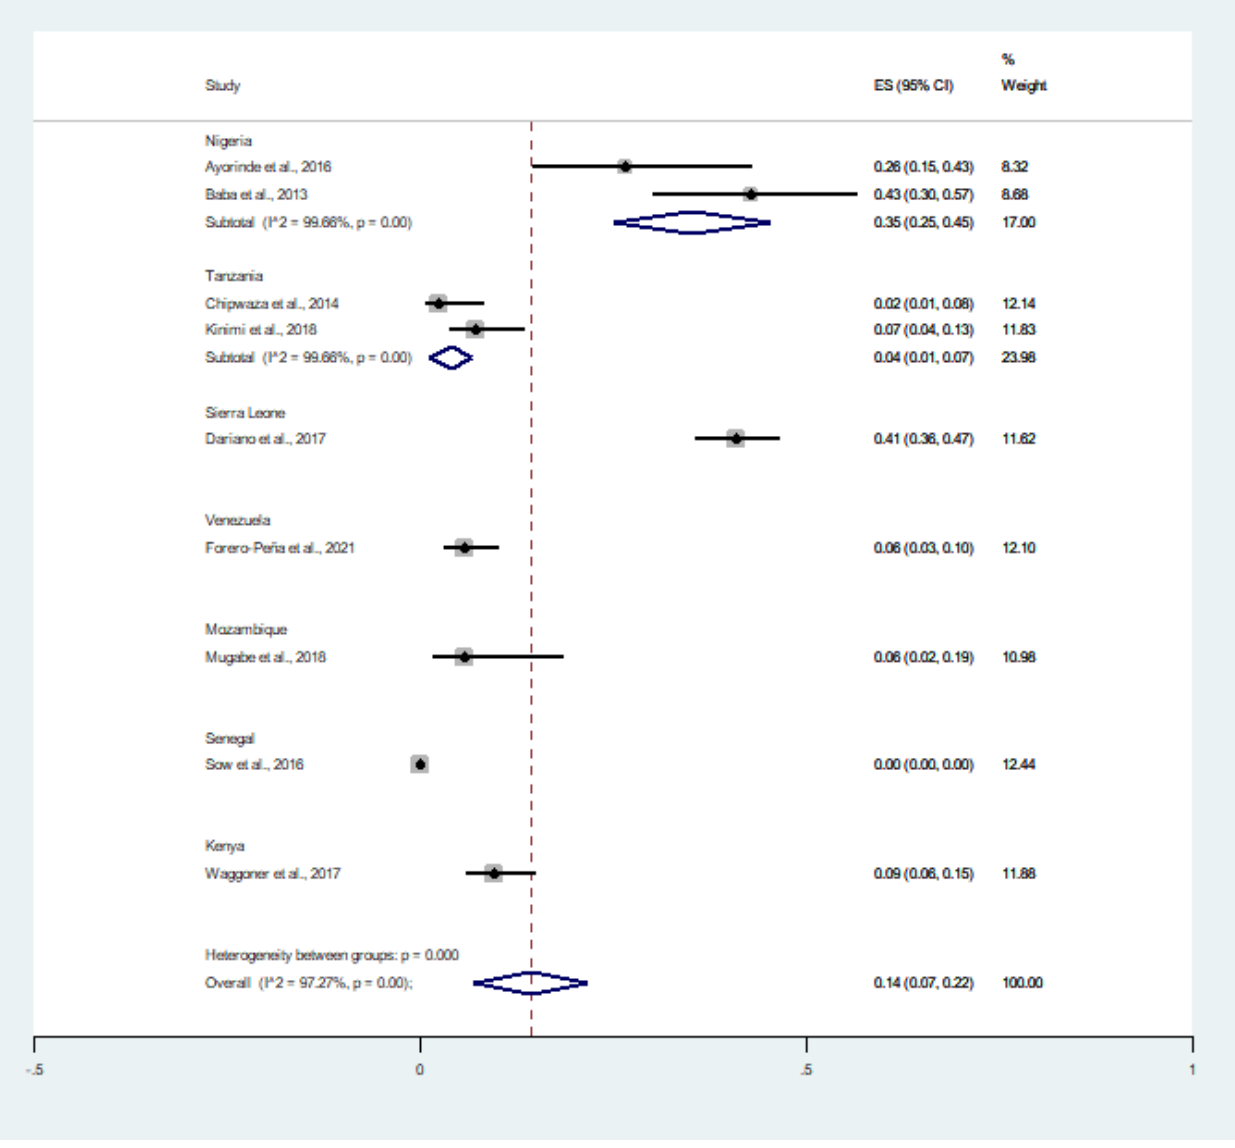
Figure 5. Prevalence of CHIKV infection among malaria patients by country: % weighted, the impact proportion of each study to the pooled effect; the black dot symbol on the black horizontal line, the point estimate for each study; the black horizontal line, CI; the white diamond symbol, the pooled prevalence; CI, confidence interval; ES, effect size (prevalence). When the prevalence was stratified as per diagnostic tests for CHIKV infection, the prevalence of CHIKV infection in malaria patients was 39% (95% CI: 34–44%, I 2 : 99.7%) using RDT (IgM), 43% (95% CI: 30–57%) using PRNT, 5% (95% CI: 3–7%, I 2 : 5.18%) using IgM and IgG ELISA, and 9% (95% CI: 6–15%) using real-time RT-PCR (Figure